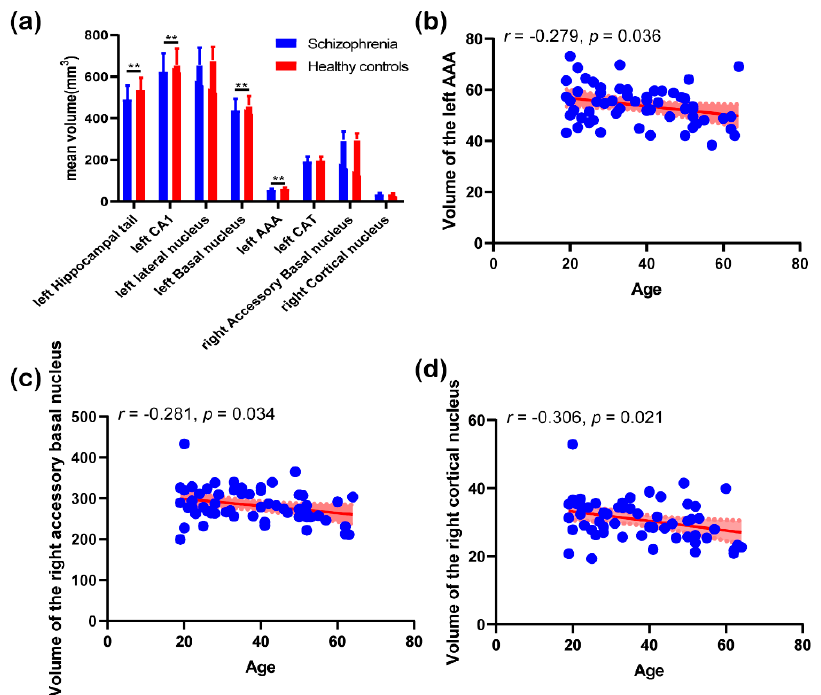
Figure 4. Results of post hoc analysis: ( a ) histogram of features with top cumulative absolute weight